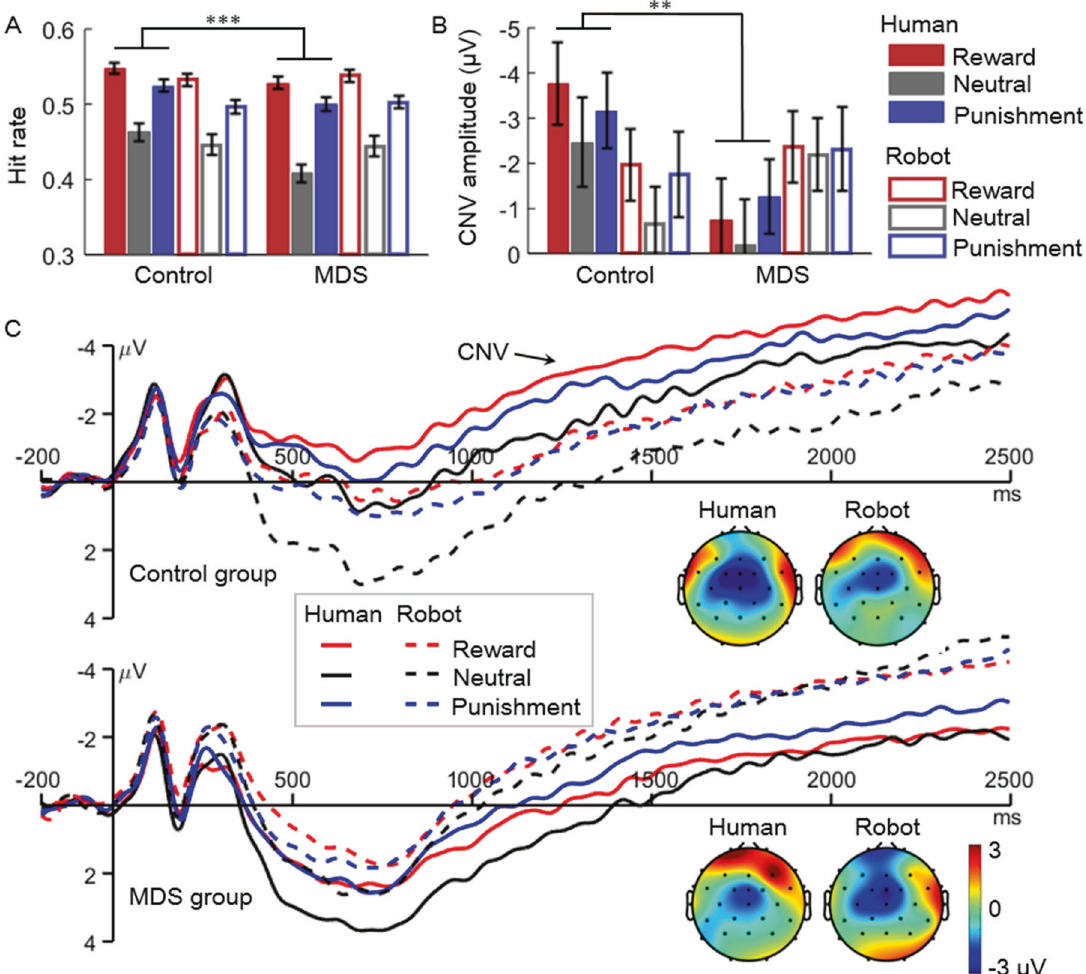
Fig. 2 The results of hit rate and the contingent-negative variation (CNV). A Hit rate in the mild depressive symptom (MDS) and control groups. B Amplitudes of the cue-evoked CNV. Error bars indicate two standard errors. ** P < 0.01, *** P < 0.001. C The CNV waveforms and topographic maps. The CNV waveforms were averaged across electrodes of Fz, FCz, FC1, and FC2. The CNV topographies were averaged across a time window of 750 – 2500 ms post cue presentation.